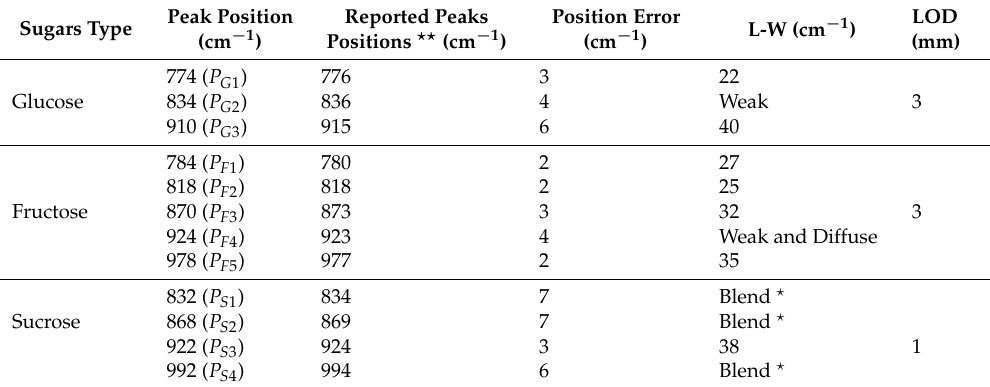
Table 1. Absorption peak signatures (fingerprint) of Glucose, Fructose, and Sucrose, the line-width of each characteristic peak and sugars LOD of microscope-FTIR spectroscopy coupled to our designed microfluidic